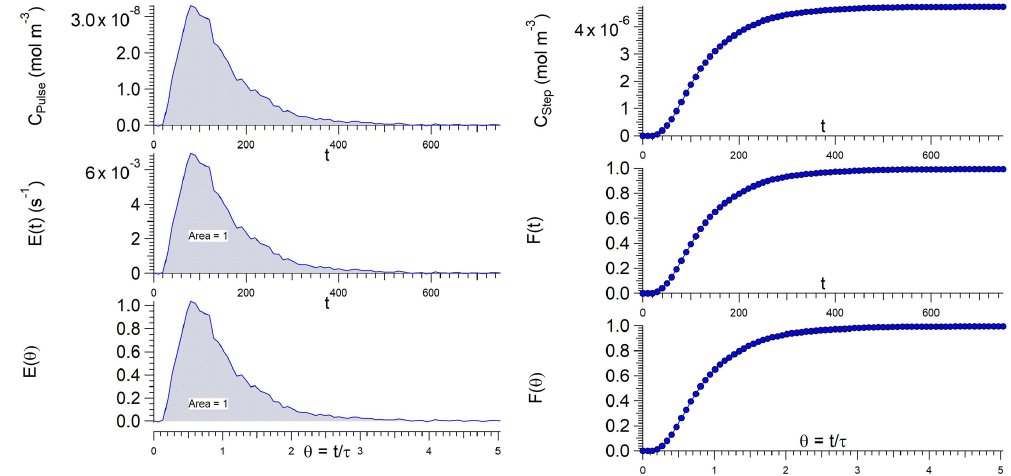
Figure 2. Tracer tests at 10Lmin − 1 (78s spacetime) through the reactor for configuration I. This figure serves as an illustrative example for non-dimensionalizing tracer response